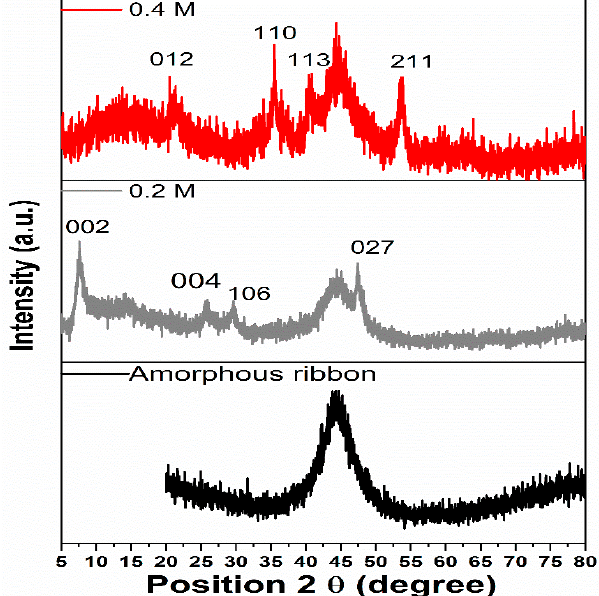
Figure 2. XRD pa tt ern of amorphous ribbons and amorphous ribbons decorated with iron oxide Figure 2. XRD pattern of amorphous ribbons and amorphous ribbons decorated with iron ox- nanoparticles. ide